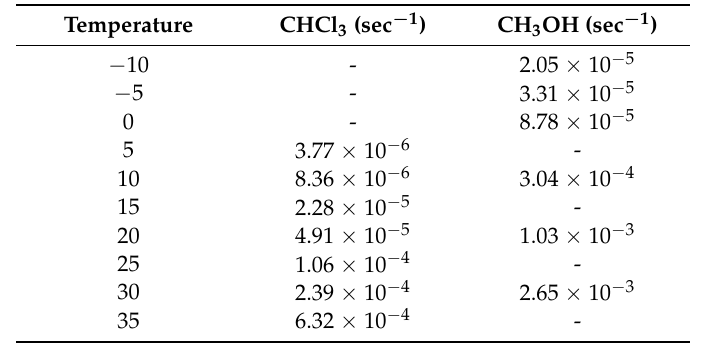
Table 1. The unimolecular rate constant of epimerization of [{ Λ -Ru(III)(acac) 2 (taet)} 3 Al(III)] in CHCl 3 and CH 3 OH.